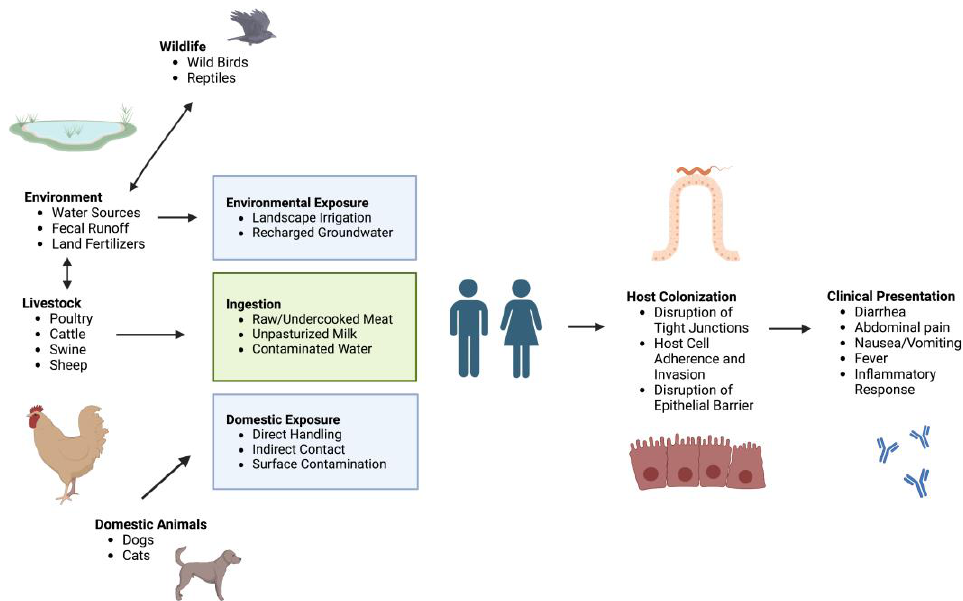
Figure 1. Schematic diagram demonstrating the relationship between the ecological dynamics and transmission of C. jejuni . Contamination of environmental resources by colonized hosts linked to cross-contamination of agriculture products, steel surfaces, and water sources. Ingestion of contaminated food products, direct handling of colonized animals, and accidental contact with contaminated environmental resources lead to human exposure to C. jejuni (left). After colonizing its host, C. jejuni adheres to the cell surface of the epithelial wall, invades the cells, and disrupts the epithelial barrier. Cellular invasion provokes an inflammatory response, which leads to the development of diarrheal symptoms. Illustration created using BioRender.